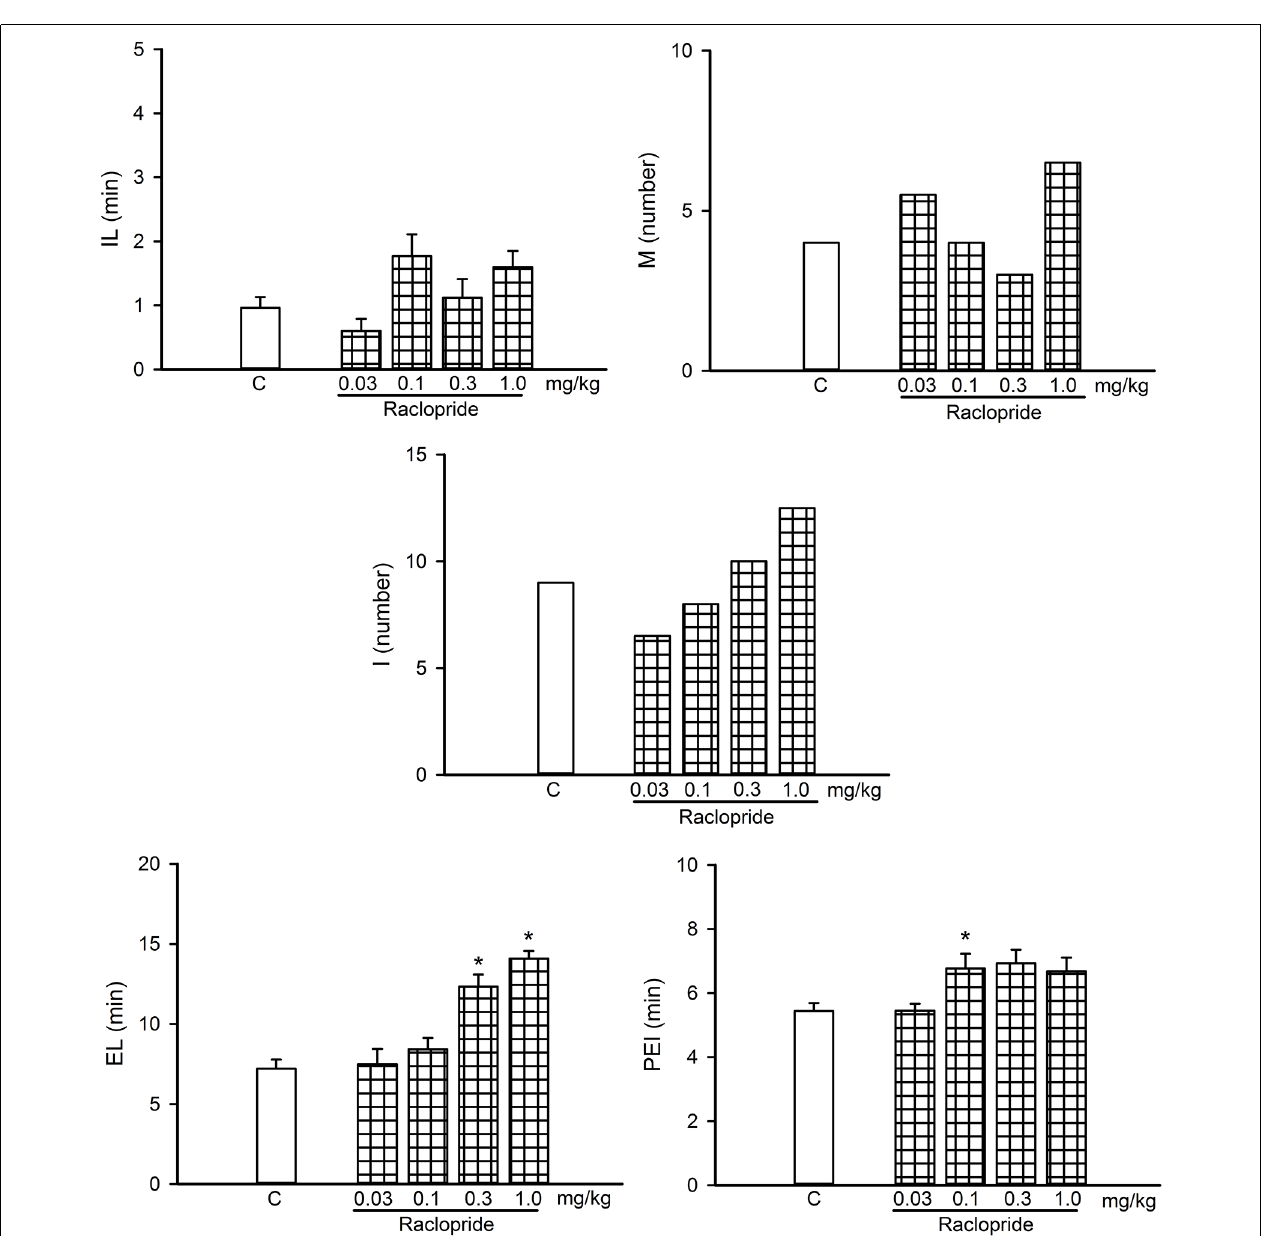
FIGURE 8 | Dose-response curve of the effects of different doses of the D2-like receptor antagonist Raclopride (0.03–1.0 mg/kg, n = 8 each) on sexual behavior of sexually experienced male rats. IL, intromission latency; M, number of mounts; I, number of intromissions; EL, ejaculation latency; PEI, postejaculatory interval; C, control. Latencies are expressed in minutes as mean ± SEM and numbers as medians. Kruskal–Wallis ANOVA followed by Dunn’s test, ∗ P < 0.05 vs.